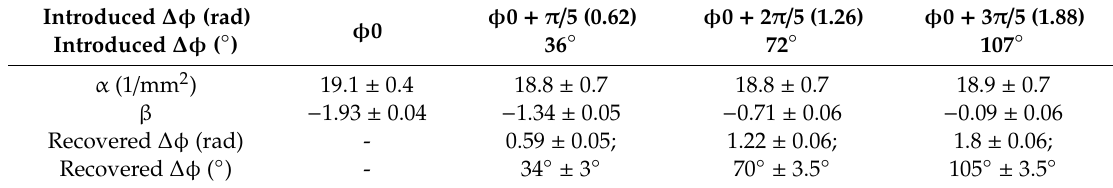
Figure 8. Spiral lines plotted over the intensity distribution in the case where different phase shifts have been introduced into the vortex beam showing rotation of the phase map. Table 1. Introduced and recovered phase shifts in the cases shown in Figure 6.